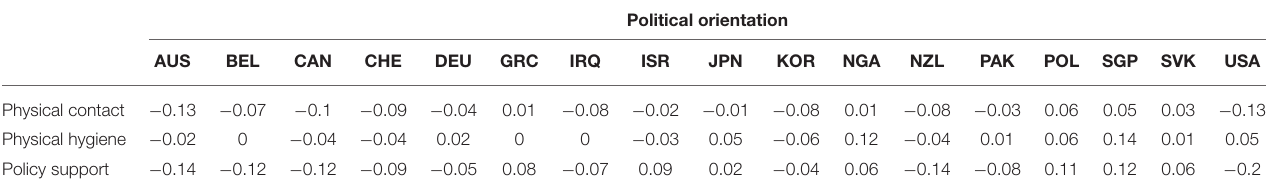
TABLE 1 | Correlations of political orientation with COVID-19 preventive behaviors and policy support across the 17 different countries ( N = 12,490). Political orientation